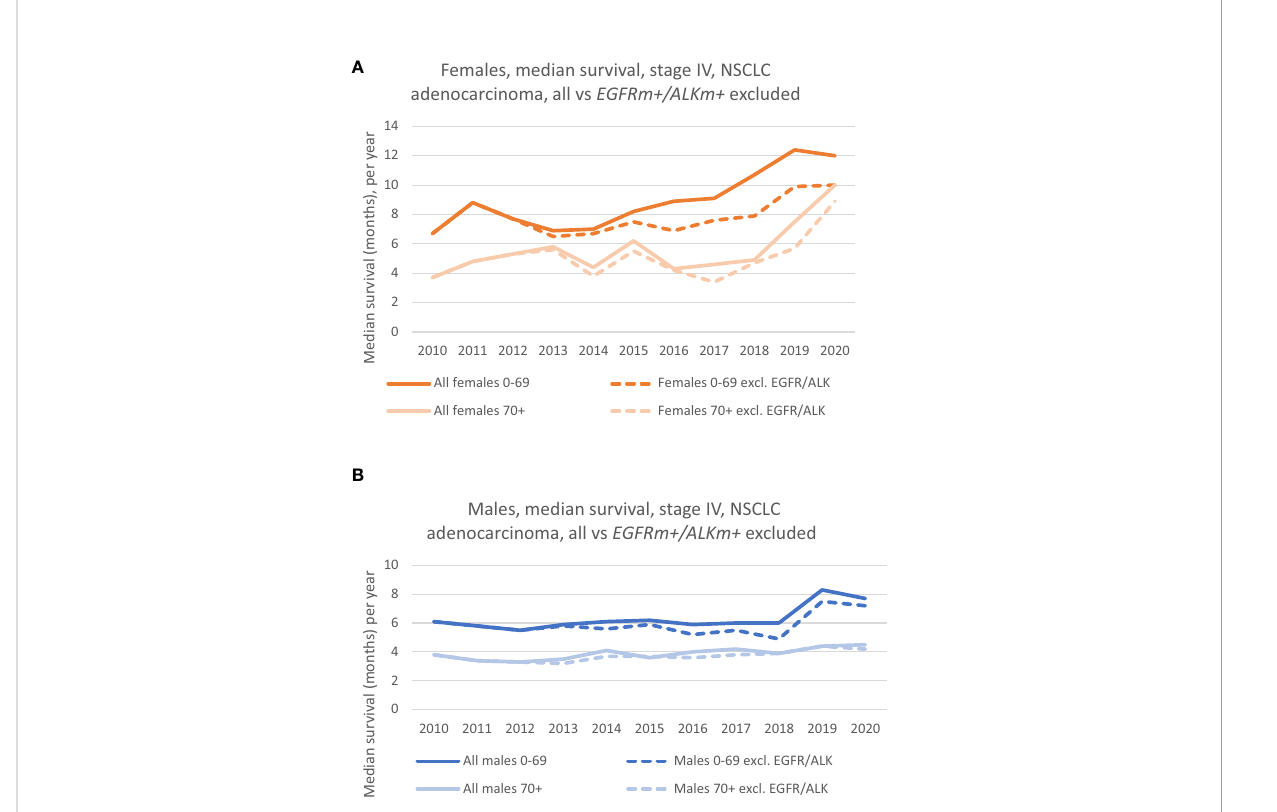
FIGURE 2 (A) Median survival of females, by age groups, where patients with EGFRm +/ ALKm+ (dotted lines) are excluded from the analysis. (Solid lines show the survival in the corresponding age group, where patients with driver mutations were included). (B) Median survival of males, by age groups, where patients with EGFRm +/ALKm+ (dotted lines) are excluded from the analysis. (Solid lines show the survival in the corresponding age group, where patients with driver mutations were